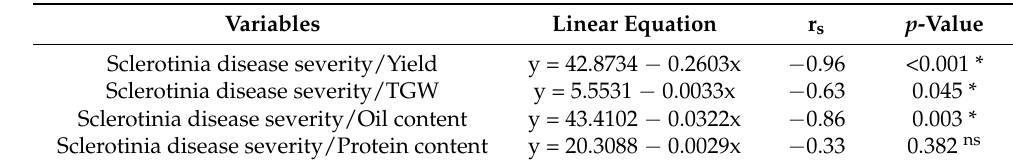
Table 3. Spearman’s rank correlation coefficient between Sclerotinia stem rot severity and yield as well as thousand grain weight (TGW), oil and protein